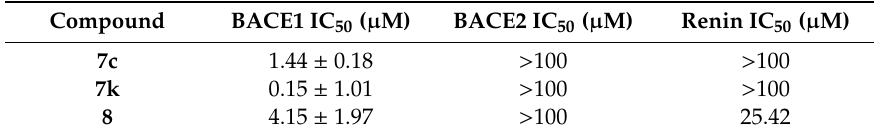
Table 6. The enzyme selectivity of compound 7c , 7k , and 8.